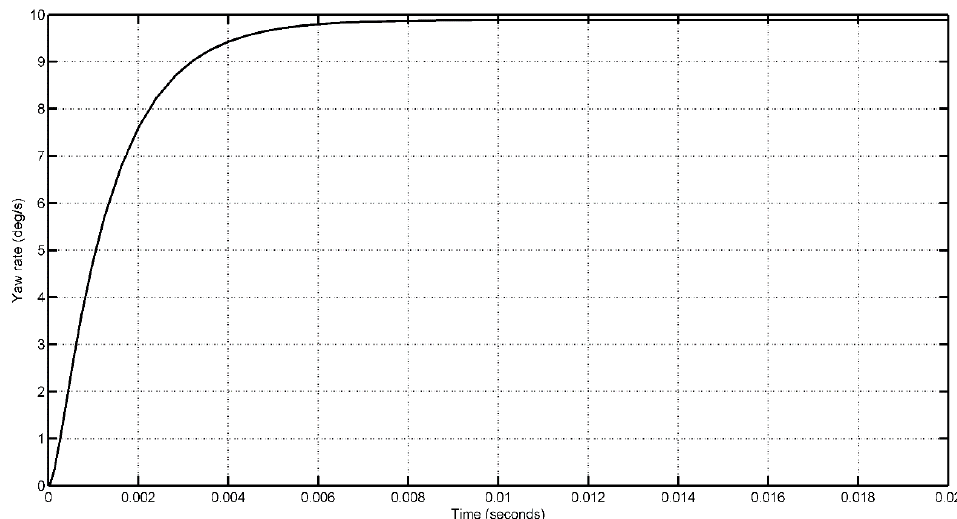
Figure 15. Yaw rate response of the octocopter with the designed proportional-integral (PI) controller for an input rate of 10 deg/s.